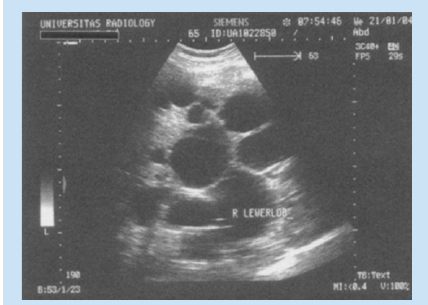
Fig.1. Ultrasound of enlarged liver.